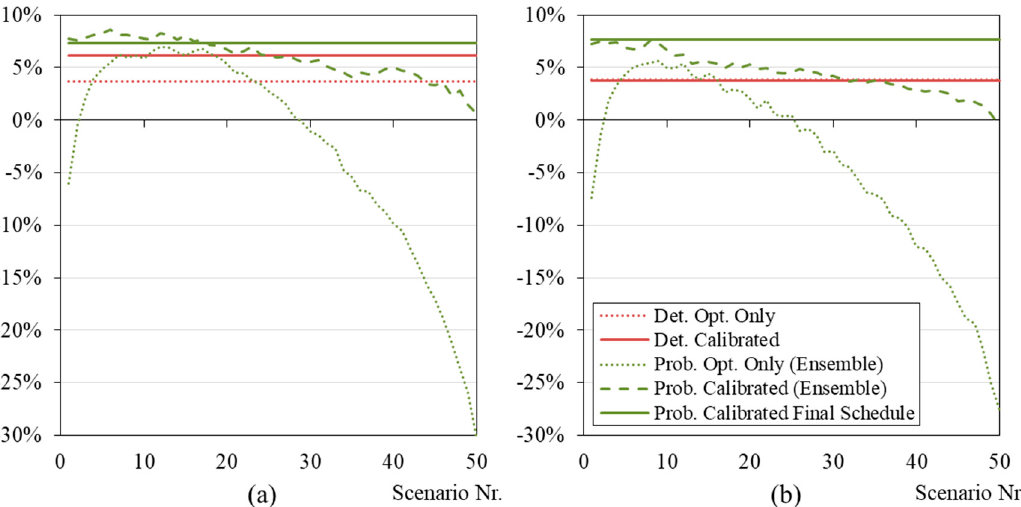
Figure 15. Financial income improvement rates in comparison to optimization-only persistence case for each scenario of the simulated cases for 2016 ( a ) and 2017 ( b ). Scenarios are sorted from minimum to maximum DNI values. The deterministic and probabilistic calibrated final schedule cases consist of a single-schedule scenario and are represented with a straight line.